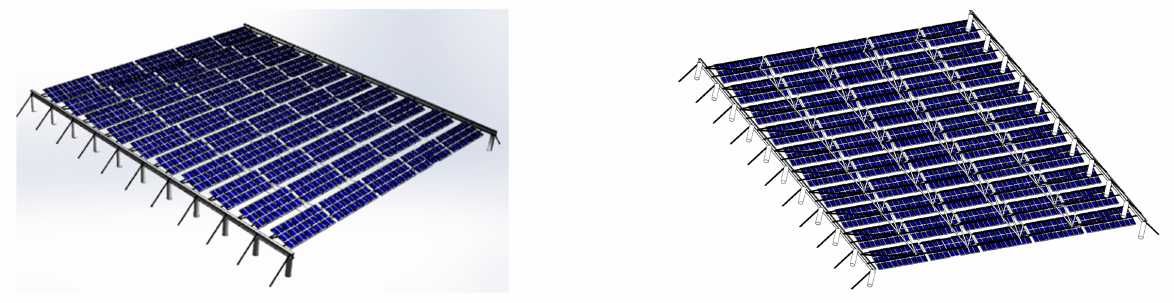
Figure 3. Sketch of the new